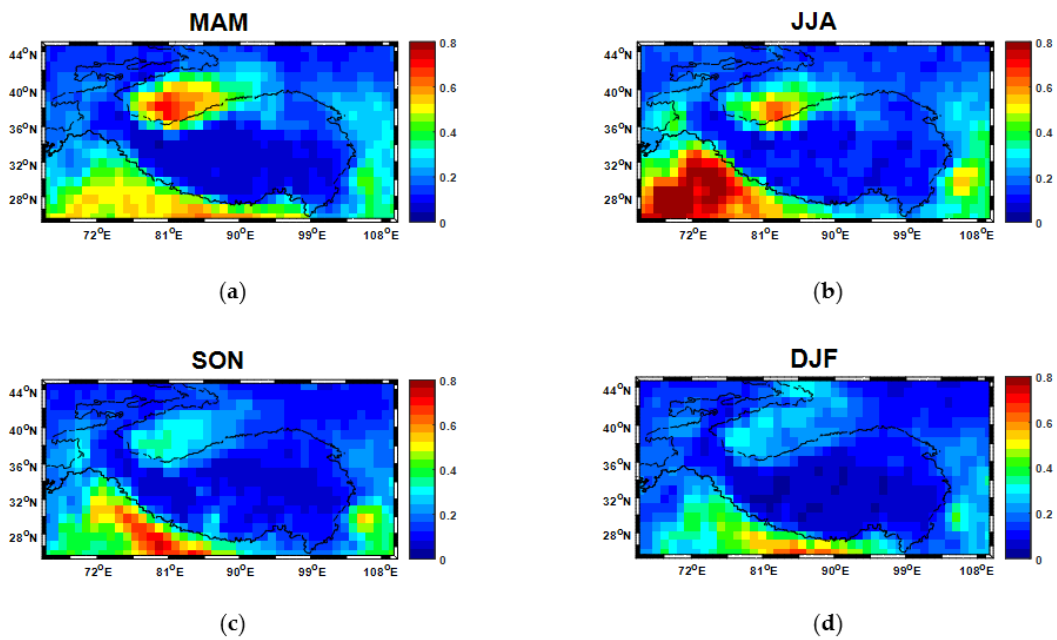
Figure 3. Seasonal maps of the AODS over the TP: ( a ) spring, ( b ) summer, ( c ) fall, and ( d ) winter over the eight-year data period from January 2007 to December 2014 (The AOD is at 532 nm and the map is gridded at 1°).